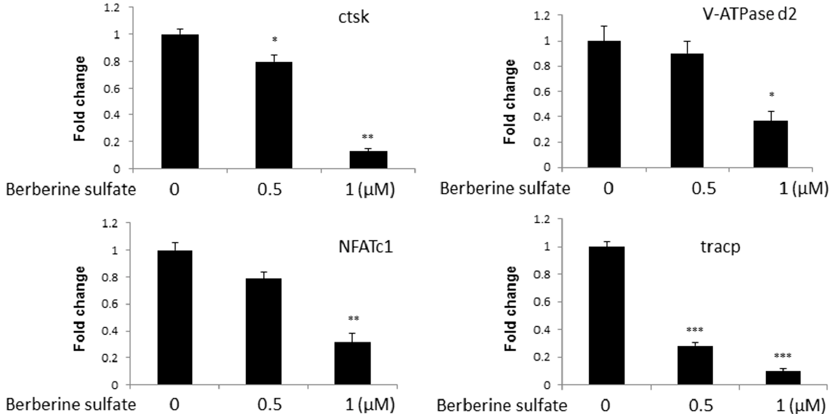
Figure 3. Effect of berberine sulfate on mRNA levels of osteoclast-associated genes. Real time-PCR and TRAcP), and results were normalized to the expression of GAPDH. * p < 0.05, ** p < 0.01, *** p < 0.001 compared with untreated control.